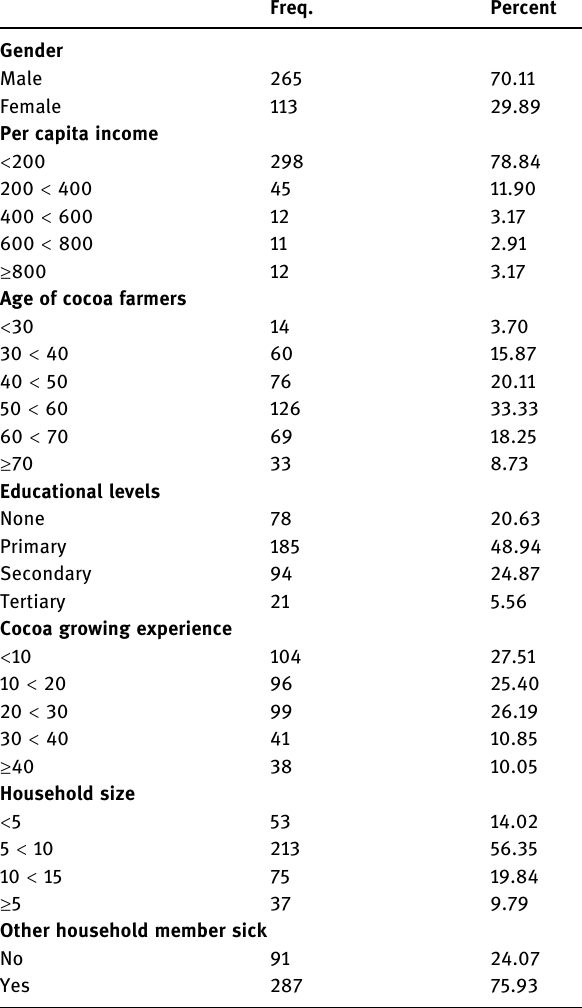
Table 2: Socioeconomic characteristics of cocoa farmers in Ahafo Ano North district